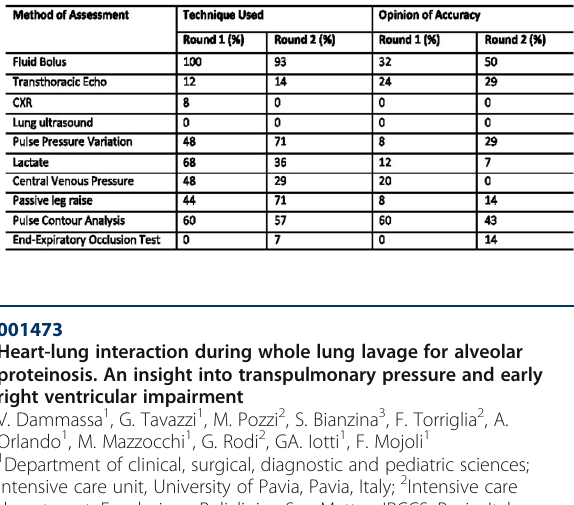
Table 1 (abstract 001344). Table showing the method of Assessment used and the opinion of their accuracy in assessing fluid responsiveness in each round